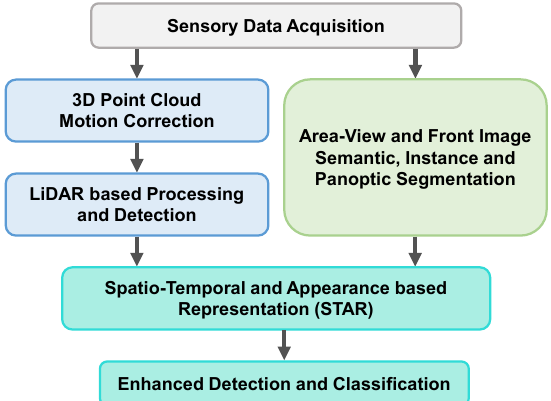
Figure 2. Overview of the enhanced perception system’s main components and their core intercon- nections: after data acquisition and pre-processing, 3D LiDAR data is processed independently of the 2D data up to the low-level fusion step which integrates the semantic information derived from the images with the corrected 3D measurements, yielding the STAR data representation which is further used for enhanced 3D detection and